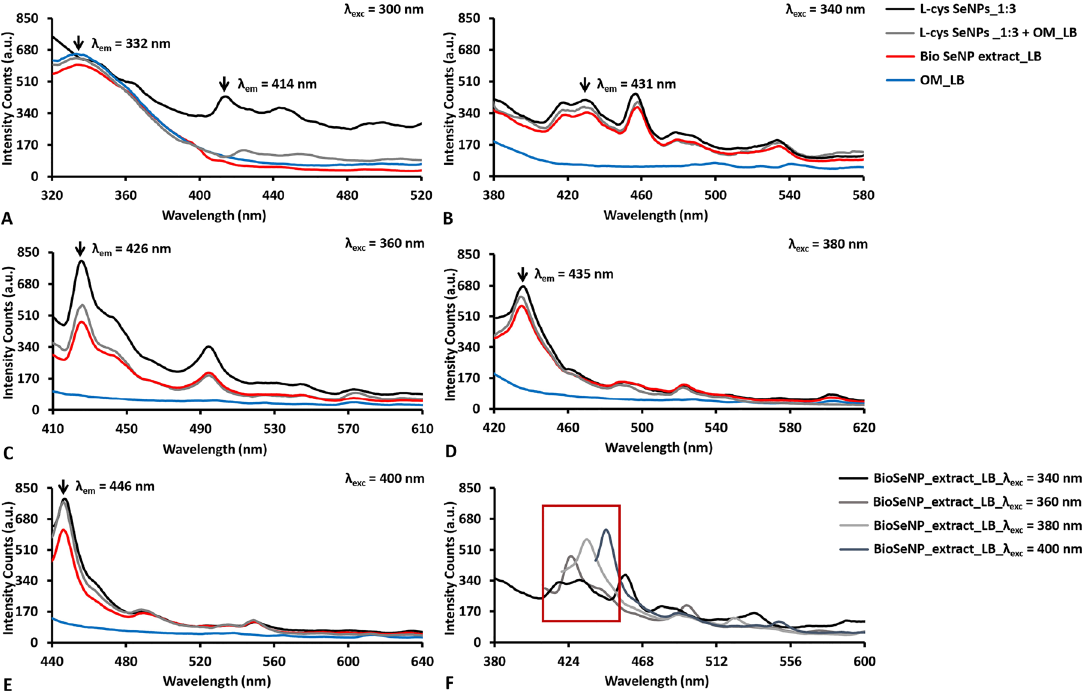
Figure 5: Emission photoluminescence spectra collected for SeNPs of ca. 50 nm as average diameter (i.e., L -cys SeNPs_1:3, Bio SeNP extract_LB,and L -cys SeNPs_1:3 + OM_LB) and their correspondingOM (ie., OM_LB)upon their excitation at (A) 300, (B) 340, (C) 360, (D) 380, and (E) 400 nm. The overlap of the obtained emission spectra for BioSeNP extract_LB is reported in (F).